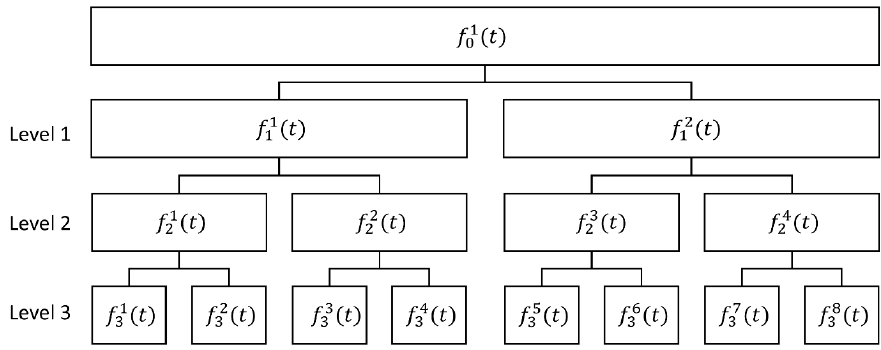
Figure 4. Schematic representation of three Wavelet Packet Transform (WPT) levels of a signal.